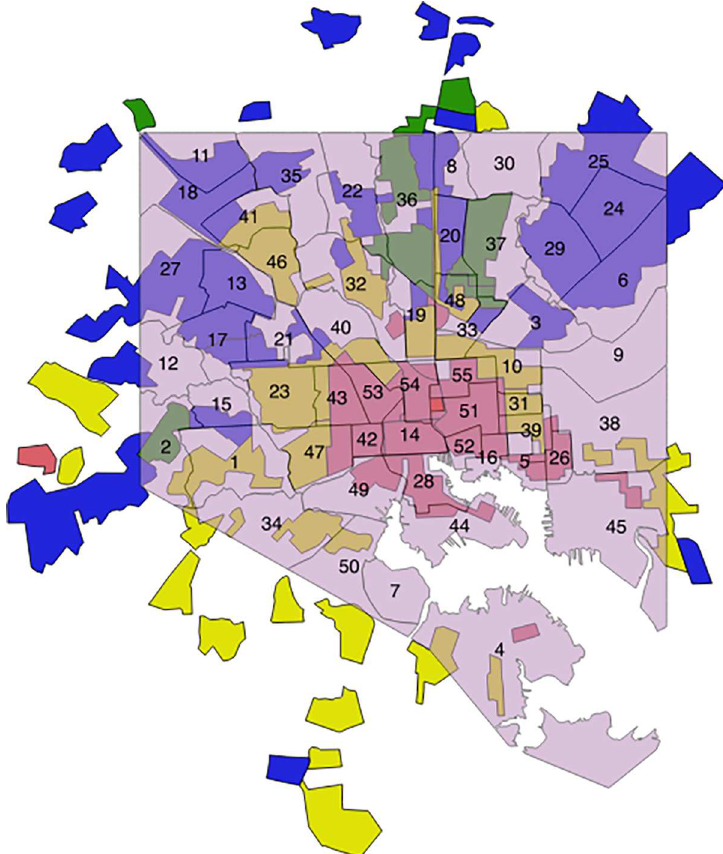
Fig 1. 2013 Baltimore CSA neighborhoods (numbers refer to CSA names) in light purple overlaid on top of HOLC redlining map (red: “Hazardous”, yellow: “Declining”, blue: “Still desirable”, green: “Best”). HOLC redlining map republished from Nelson RK, Winling L, Marciano R, Connolly N, et al. Mapping Inequality. n.d. [cited 2017 Nov 6]. In: Nelson RK, Ayers EL, eds. American Panorama [Internet]. Richmond: University of Richmond Digital Scholarship Lab. Available from: https://dsl.richmond.edu/panorama/redlining/#loc=11/39.293/-76.808&city= baltimore-md under a CC BY license, with permission from University of Richmond Digital Scholarship Lab, original copyright